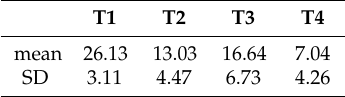
Table 1. Mean and SD of integrins expression in different groups.